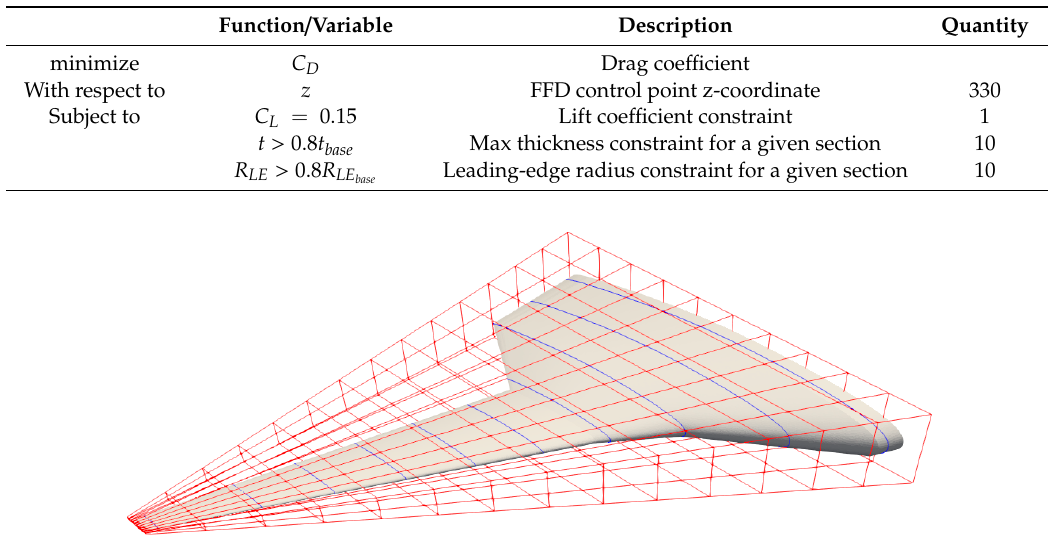
Table 7. Comparison of key aircraft parameters of reference long range aircraft SE²A-LR and B777 using high-fidelity analysis.